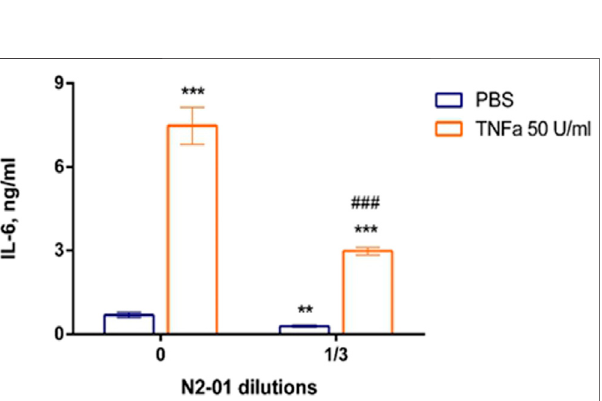
FIGURE 7 | The effect of N2-01 on the IL-6 productions by human umbilical endothelial cells. Statistical assessment of differences was performed using ANOVA ( p < 0.001), and pairwise comparison of the mean values was performedusingtheTukeyHSD test. Dataareexpressedasmean ± SEM ofnineindividualexperiments( n (cid:2) 9).Thedifferencesaresigni fi cant:**- p < 0.01 vs control, *** - p < 0.001 vs control; ### - p < 0.001 vs TNF α